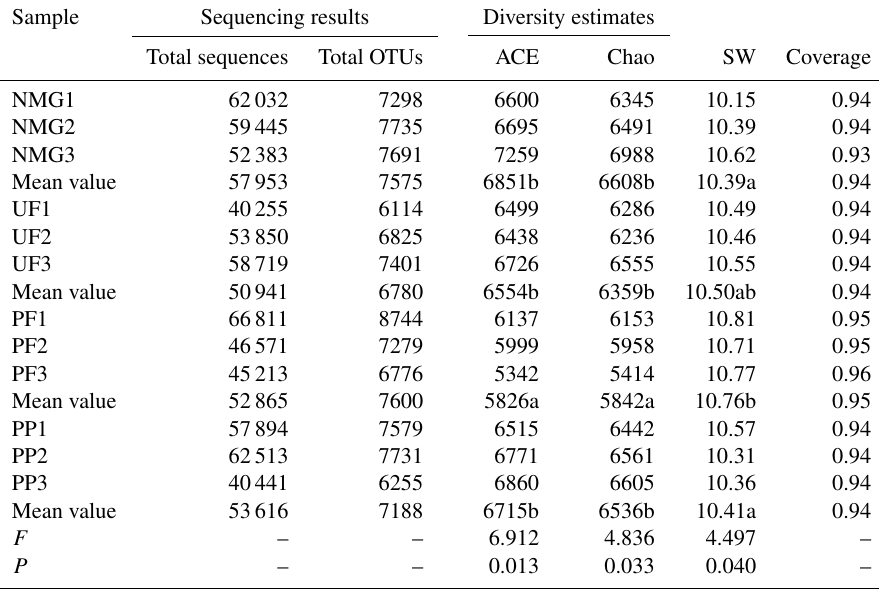
Table 2. MiSeq sequencing results and diversity estimates for each sampling